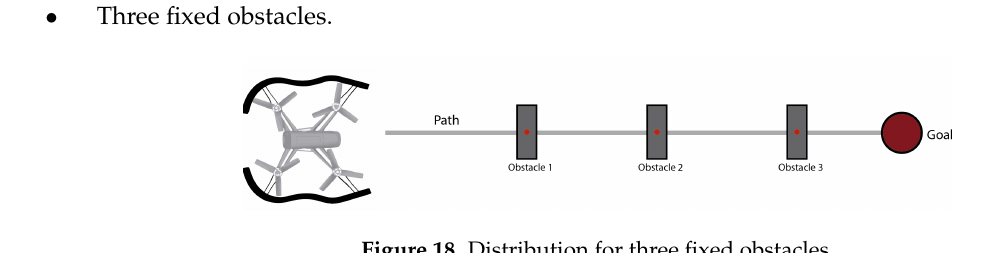
Figure 18. Distribution for three fixed obstacles.